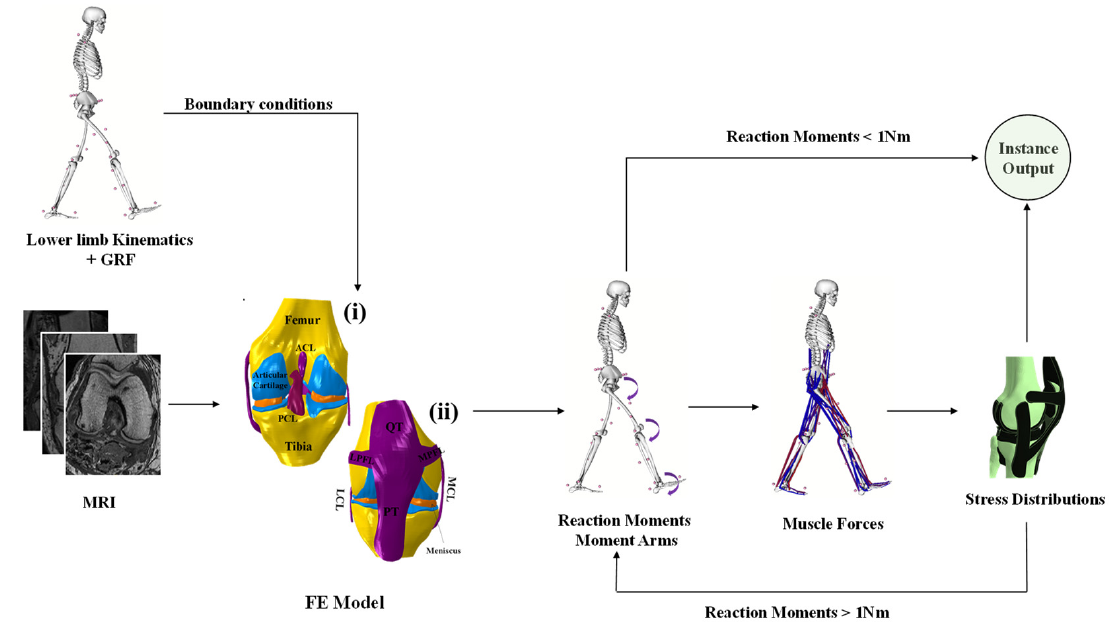
Figure 1. The workflow considered during this study with an anterior (i) and posterior (ii) view of the knee’s three-dimensional finite element model shows the corresponding soft tissues and articular surfaces acting on the bones. Anterior cruciate ligaments (ACLs), posterior cruciate ligaments (PCLs), medial and lateral collateral ligament (MCL and LCL), lateral patellofemoral (LPL), medial patellofemoral (MPL), quadriceps tendon (QT), and patellar tendon (PT) cartilage layers and menisci are shown. Muscles surrounding the knee joint were applied as surface traction [41,42]. More details on the system of axes, the joint center calculations, and muscles characteristics can be found in [29,40].